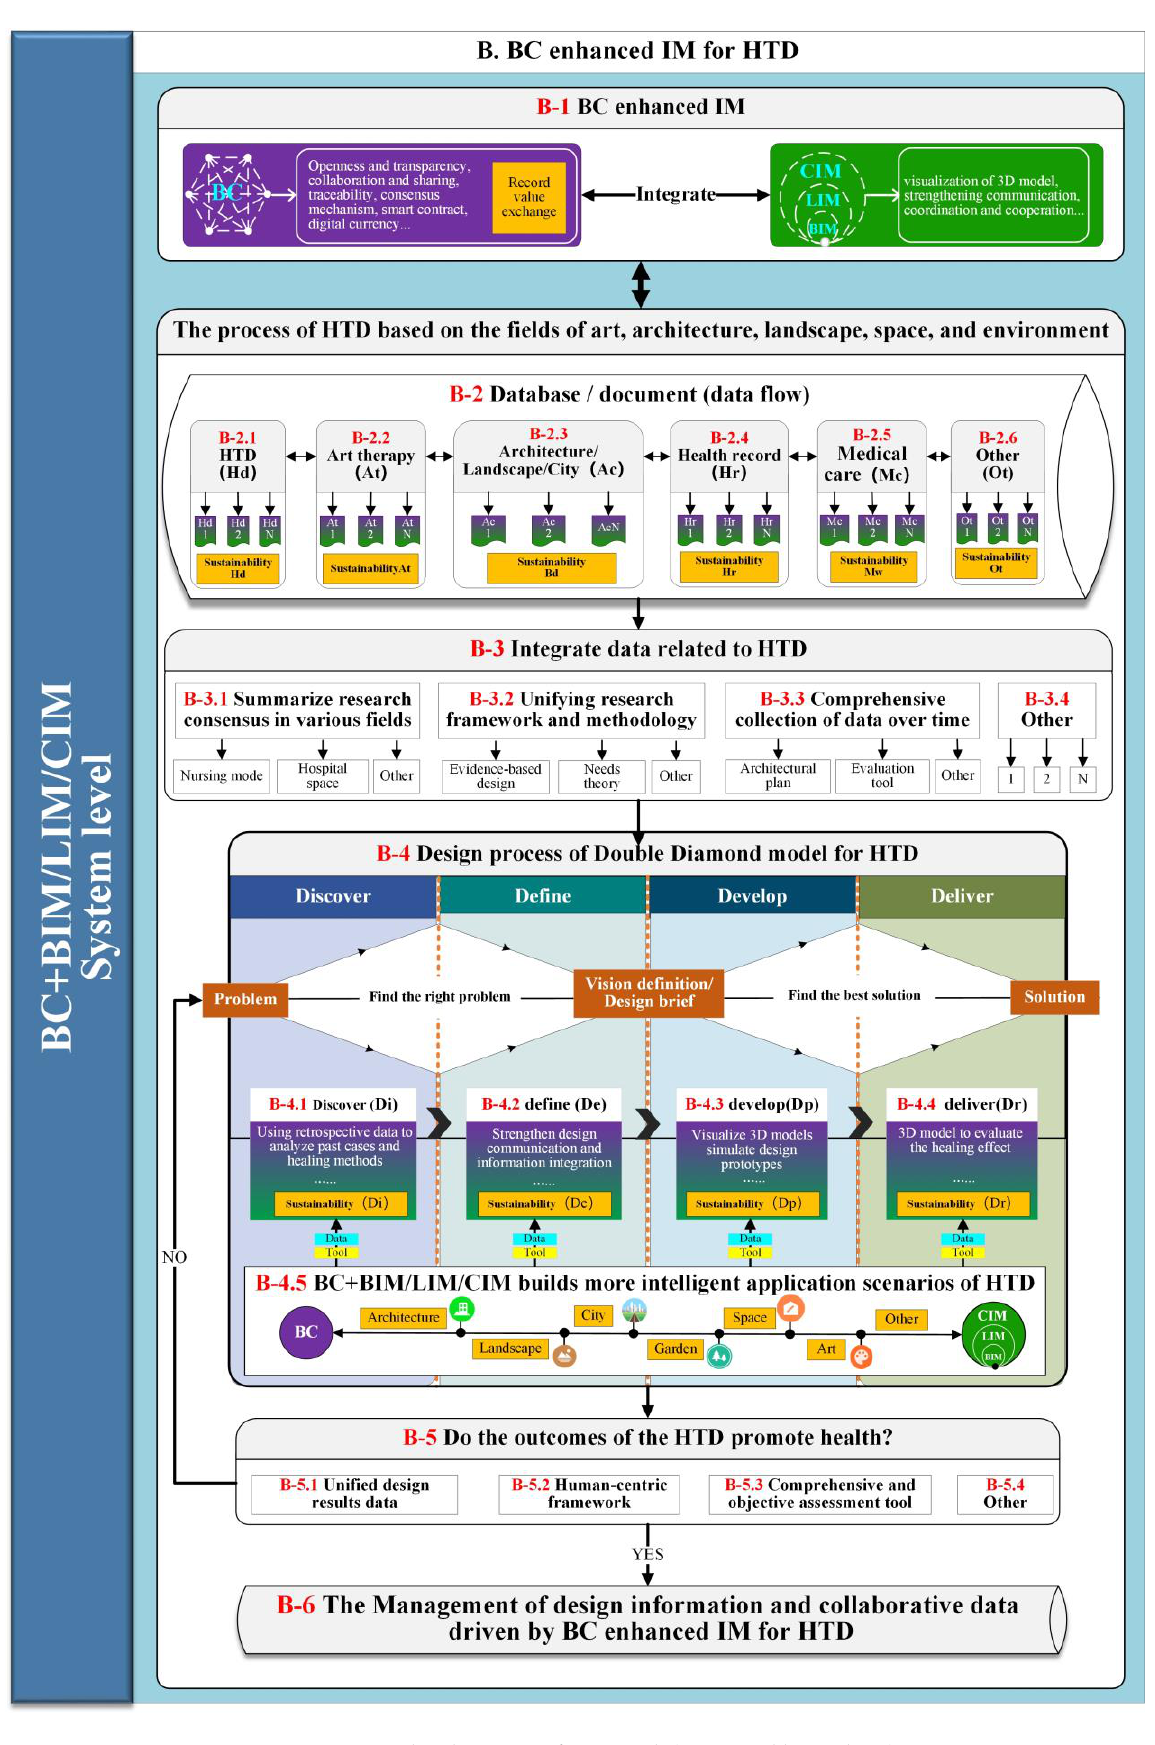
Figure 10. Low-level BC-HTD framework (generated by authors).